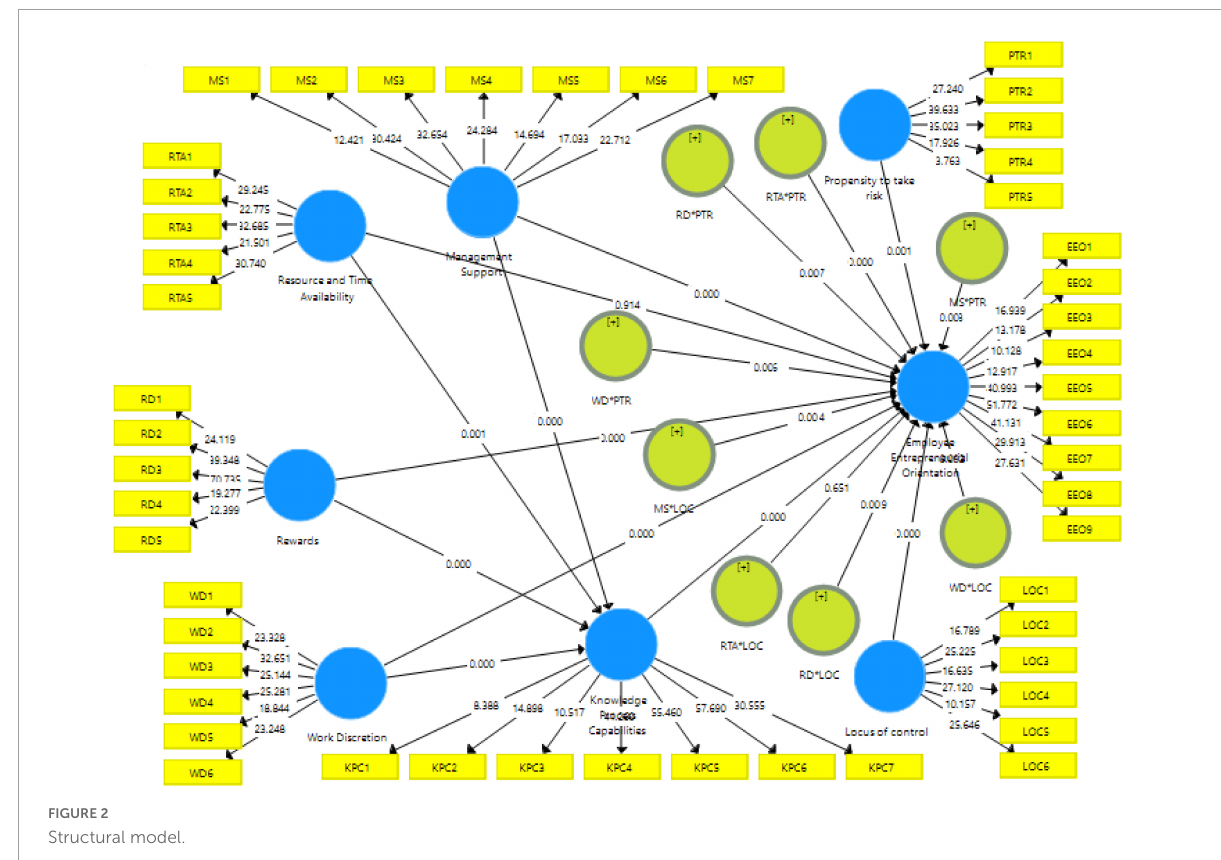
FIGURE2 Structural